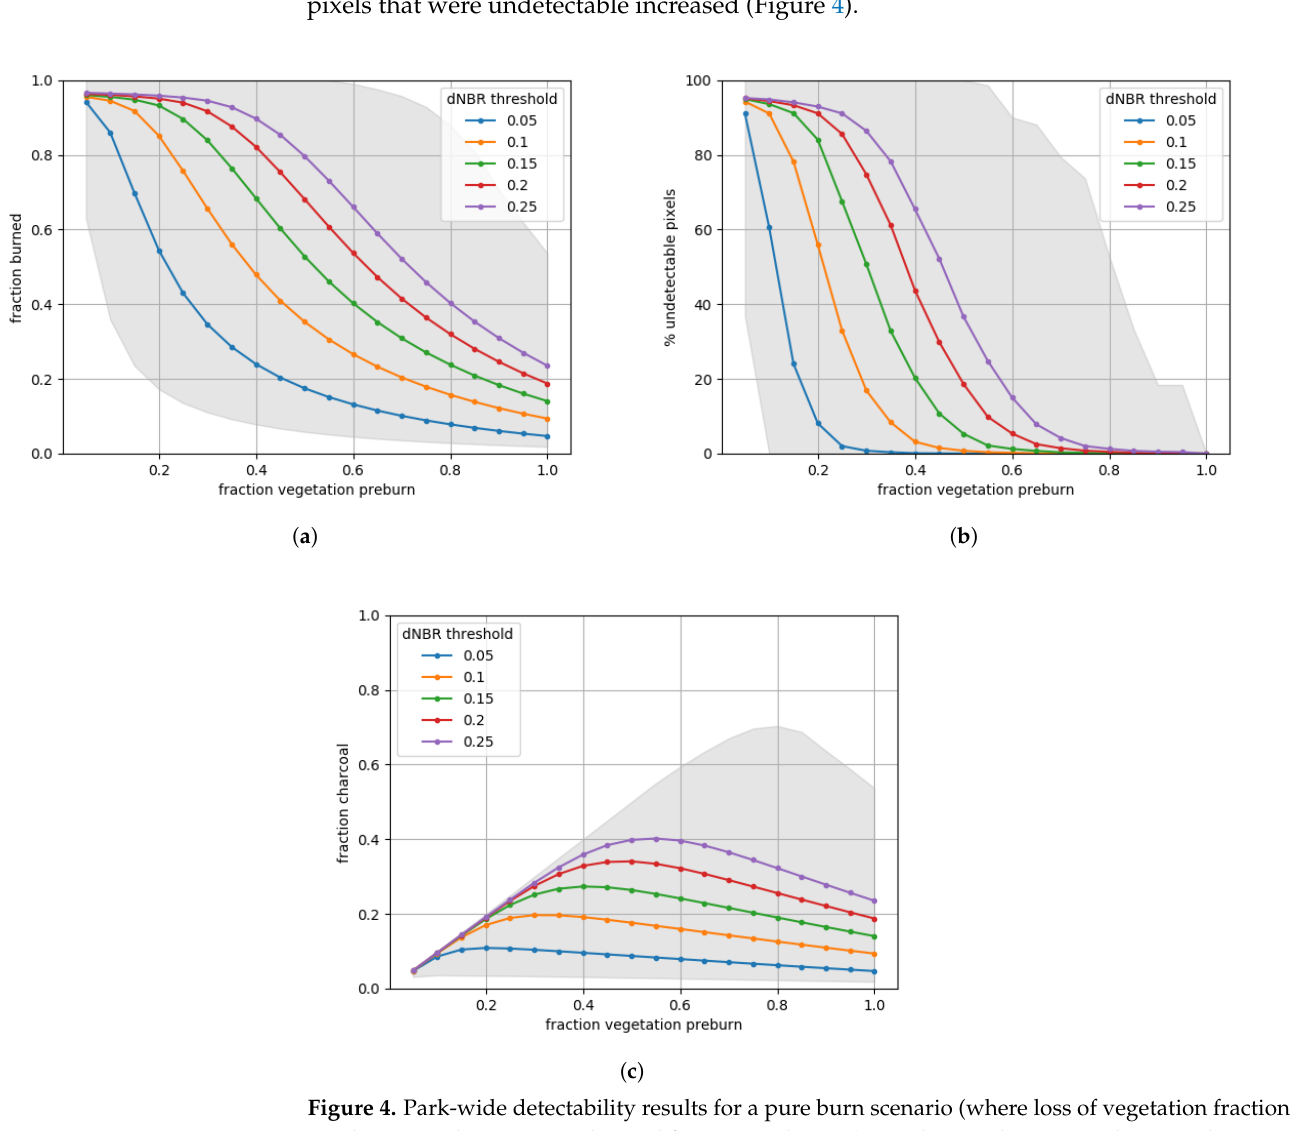
Figure 4. Park-wide detectability results for a pure burn scenario (where loss of vegetation fraction results in equal increase in charcoal fraction ( ∆ char = 1), Landsat 8. The mean values are shown in colored lines, with total model result variation shown in gray. ( a ) Fraction of vegetation burned at detection. ( b ) Percentage of undetectable pixels. ( c ) Charcoal contribution on